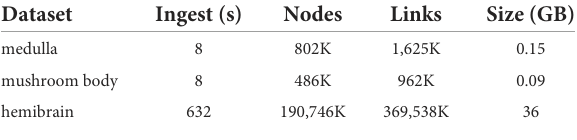
ingestion was performed on a machine with 256GB of memory and 20 processors.